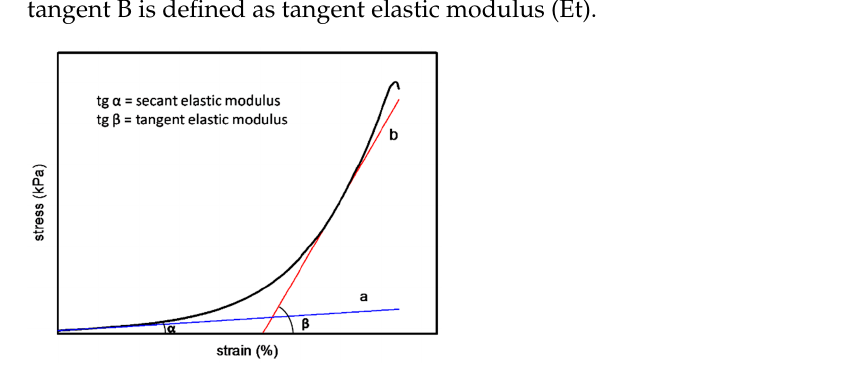
Figure 1. The illustration for secant elastic modulus and tangent elastic modulus.